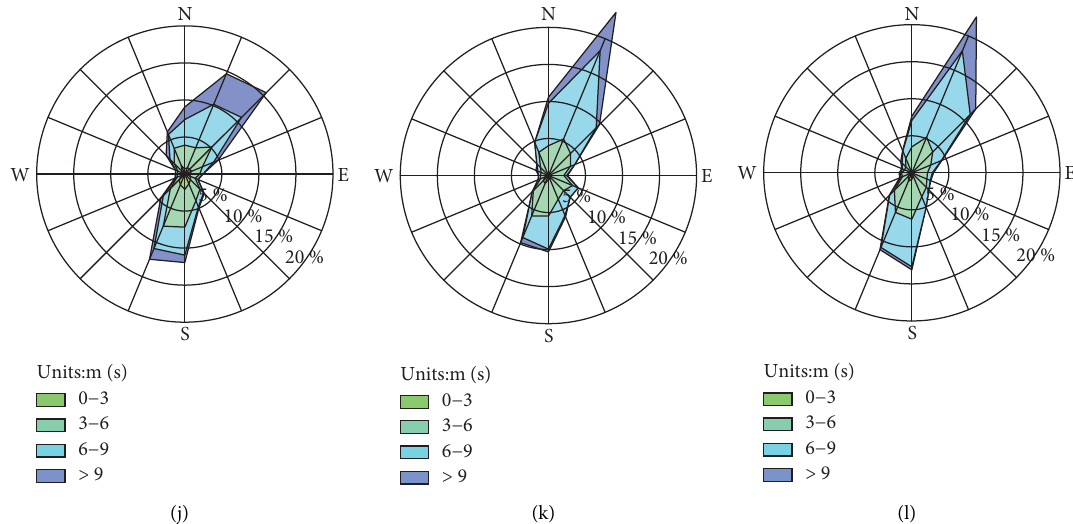
Figure 6: The wind rose plots for the observations, the ERA5 predictions and the MERRA2 predictions based on the MLR downscaling method. (a) T 1-Obs. (b) T 1-ERA5. (c) T 1-MERRA2. (d) T 2-Obs. (e) T 2-ERA5. (f) T 2-MERRA2. (g) T 3-Obs. (h) T 3-ERA5. (i) T